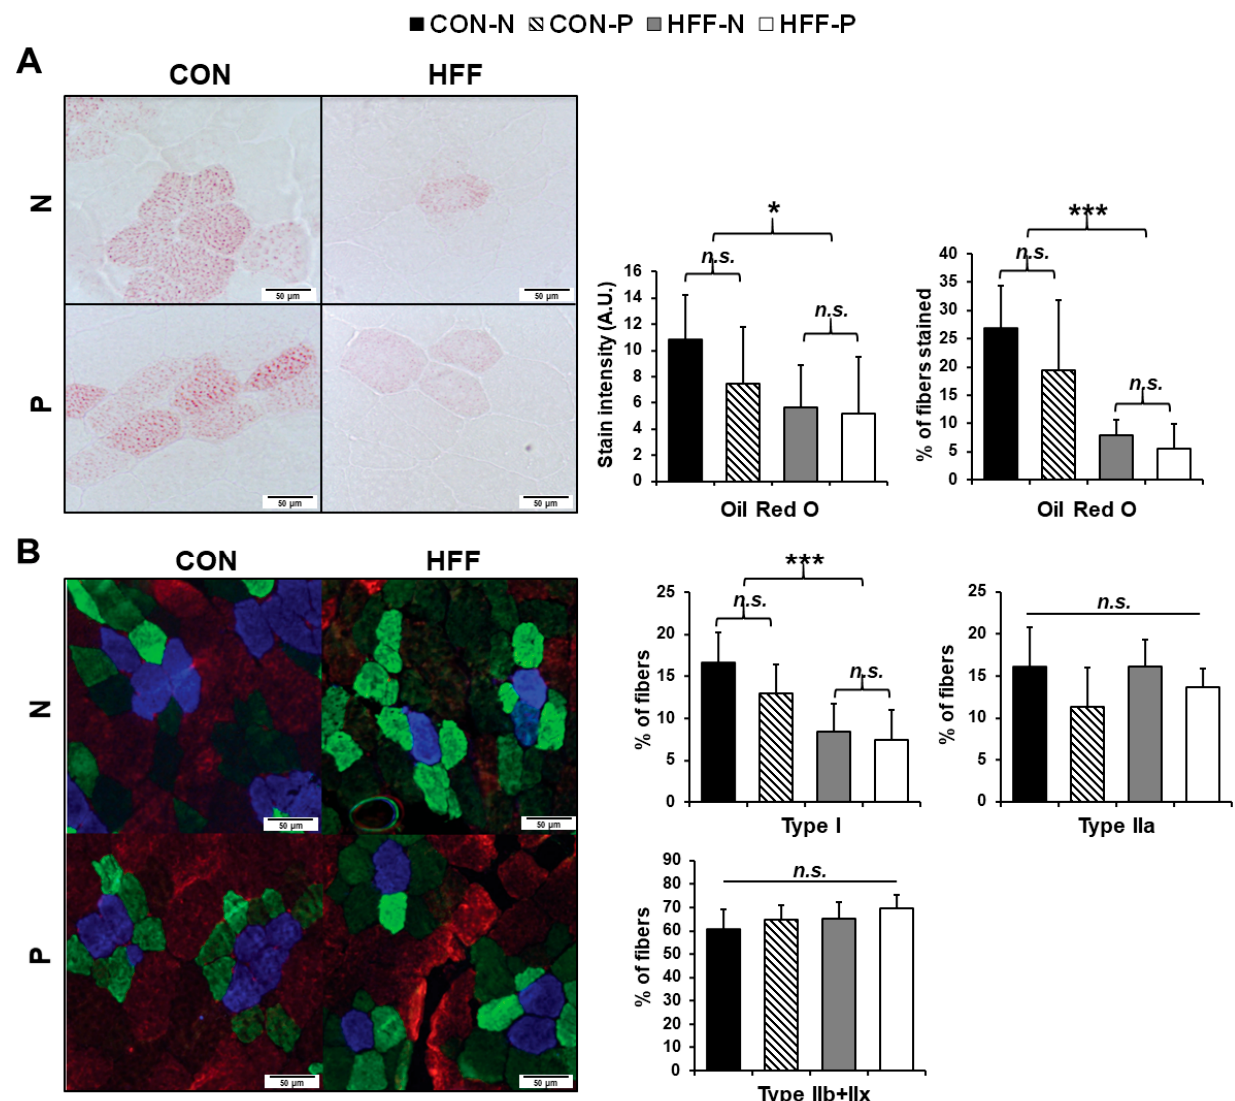
Figure 2. Effect of high-fructose, high-fat diet (HFF) on intramyocellular lipid (IMCL) content and skeletal muscle fiber type in juvenile Iberian pigs (n = 20). ( A ) Representative image of Oil red O (ORO) staining of longissimus dorsi muscle fibers [400× total magnification] with percentage of fibers staining with ORO (n = 3646) and ORO stain intensity (n = 918) (arbitrary units (AU)) demonstrating decreased IMCL in HFF-fed compared with CON-fed pigs; ( B ) representative image of immunohistochemical fiber typing of longissimus dorsi muscle [400× total magnification] with the total percentage of type I, type IIa, and type IIb/x fibers stained (n = 12682) indicating a decrease in type I slow oxidative fibers. Blue stained cells—Type I skeletal muscle fibers; green-stained cells—Type IIa; red-stained cells—Type IIb; unstained cells—Type IIx; CON—control; CON-N—control diet without probiotic supplementation; CON-P—control diet with probiotic supple- mentation; HFF-N—high-fructose, high-fat diet without probiotic supplementation; HFF — P-high-fructose, high-fat diet with probiotic supplementation. Statistical significance between groups is indicated by * ( p ≤ 0.05), *** ( p ≤ 0.001). Non- significant differences between groups are indicated by “n.s.’’. HFF diet leads to a less oxidative skeletal muscle phenotype. There were significantly fewer type I slow oxidative muscle fibers in HFF-fed pigs as compared to CON ( p ≤ 0.001; Figure 2B), matching the decrease in cells stained with ORO. Although probiotic effects on fiber type were not significant ( p > 0.05), type I slow oxidative fibers appeared to be further decreased in the probiotic cohorts of each dietary group (Figure 2B). There were no significant differences between treatment groups in proportions of the other fiber types (type IIa fast oxidative, type IIx, type IIb, or hybrid fibers) ( p > 0.05; Figure 2B).